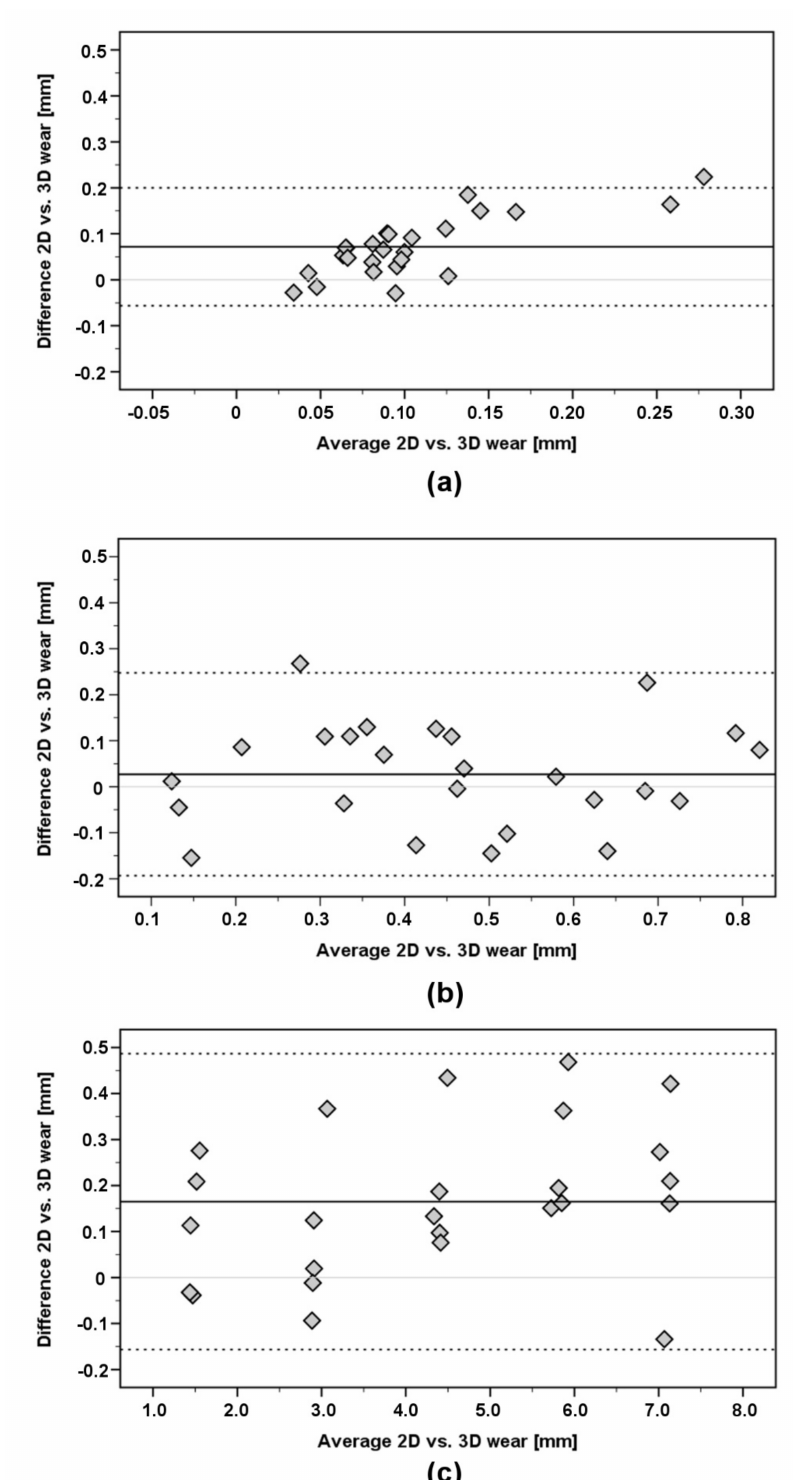
Figure 5. Bland–Altman [28] scatter plots in the pelvic neutral position between 2D wear and 3D wear for ( a ) the low wear group ( b ) the medium wear group and ( c ) the high wear group. Each data point of the plots presents the computed differences between the 2D wear and 3D wear approach (ordinate), which is plotted versus the mean difference (abscissa) of both methods, respectively. LoA is visualized by the horizontal lines, representing the mean value of calculated differences, and the two dashed lines (mean ± 1.96 SD) represent bounding